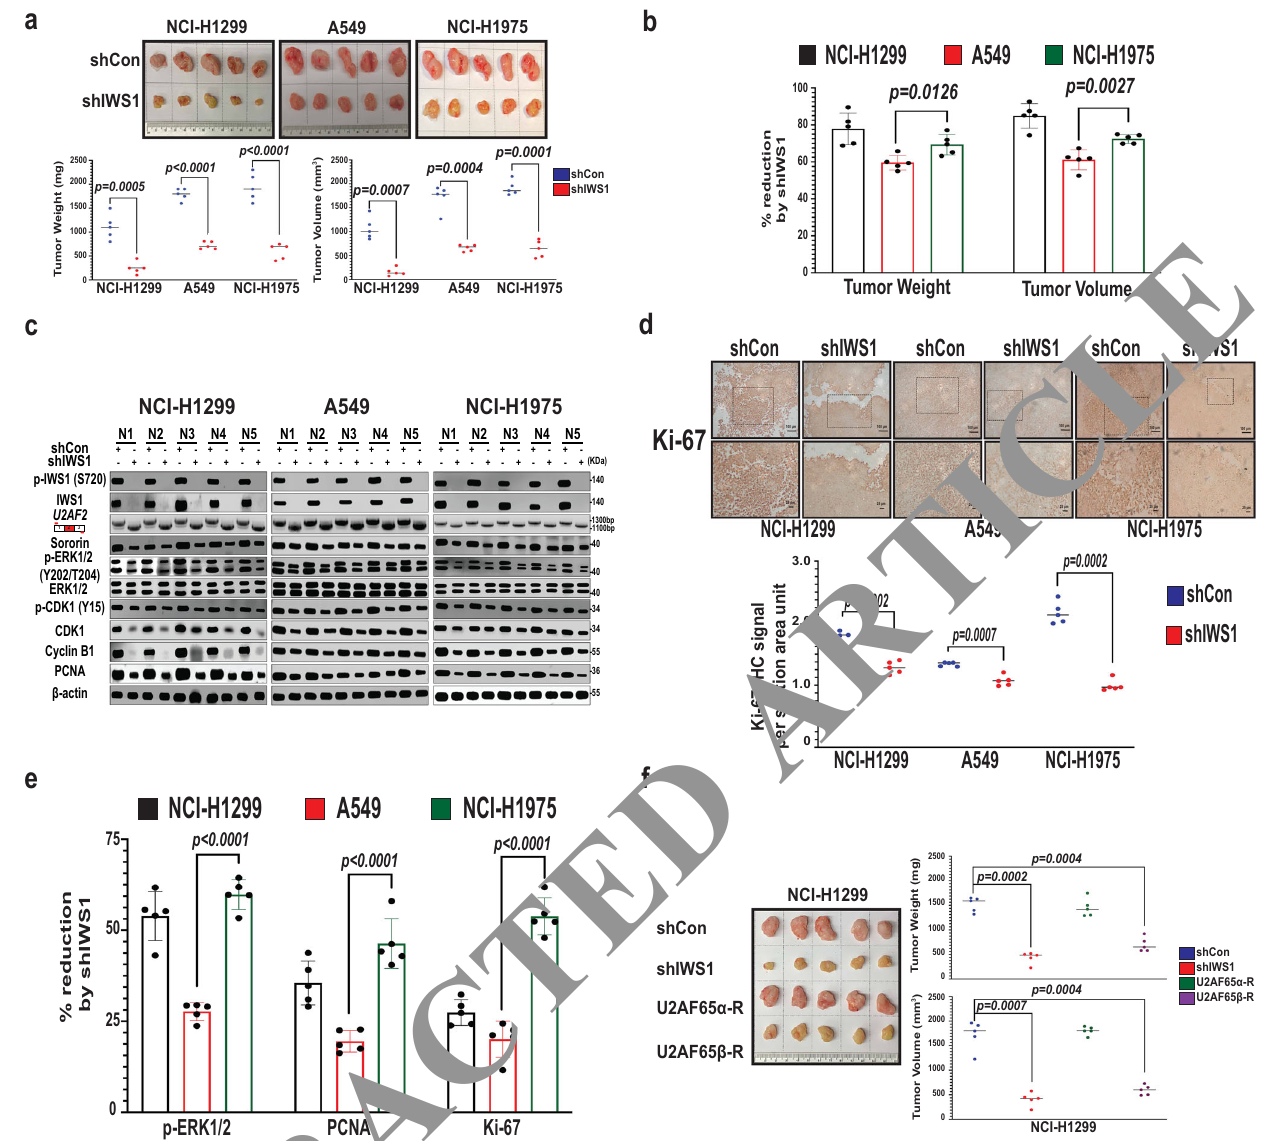
Fig. 7 IWS1 phosphorylation controls tumour growth in vivo, by regulating the U2AF2/Sororin/ERK axis. a (Upper panels) NSG mice were injected subcutaneously with shControl or shIWS1 NCI-H1299, A549, or NCI-H1975 cells. ( N = 5 mice/group). Images of tumors, harvested at 4 weeks (NCI- H1299, NCI-H1975) or 6 weeks (A549) from the time of inoculation. (Lower panels) Scatter plots showing the weight and volume of individual tumors. The horizontal lines indicate mean tumor weight or volume. Statistical analyses were done using the one-sided paired t -test. b shIWS1-induced percent reduction of tumor weight and tumor volume, calculated from the weight and volume of the tumors induced by shIWS1 and shControl cells in panel a . Bars show the mean percent reduction±SD. Statistical analyses were done using the one-sided unpaired t-test. c Cell lysates derived from NCI-H1299, A549 and NCI-H1975 (shControl and shIWS1) mouse xenografts, were probed with the indicated antibodies. RT-PCR on RNA from the same cells, using primers for U2AF2 exons 1 and 3. d (Upper panels) The indicated shControl and shIWS1, formalin- fi xed, paraf fi n-embedded tumor samples were stained with the Ki-67 antibody. Boxes in the upper images delineate the area of higher magni fi cation shown in the lower images. Scale bar in the right lower corner of each image. (Lower panels) Scatter plots show the Ki-67 IHC signal per section area unit in shControl and shIWS1 tumors. The horizontal lines show mean Ki-67 signals. Statistical analyses were performed, using the one-sided paired t -test. e ShIWS1-induced percent reduction of the phosphor-ERK, PCNA and Ki-67 signals in the xenograft tumors. Bars show the mean signal reduction, based on quanti fi cation of the Western blot data in panel c (p-ERK and PCNA) and IHC data in fi gure 7e (Ki-67) ± SD. Statistics were performed using the one-sided unpaired t -test. f (Left panels) shControl, and shIWS1 NCI-H1299 cells, as well as shIWS1 NCI-H1299 cells rescued with U2AF65 α , or U2AF65 β , were injected subcutaneously in NSG mice, as in the experiment in panel a ( N = 5 mice/group). Images of tumors harvested at 4 weeks from the time of inoculation. (Right panels) Scatter plots showing the weight and volume of the harvested tumors. The horizontal lines indicate mean tumor weight or volume. Statistical analyses were performed with the one-sided paired t -test. Analysis of the molecular signature dataset GSE13213, which (Fig. 8f, left panel). Sorting tumors harboring EGFR or KRAS focuses on tumor relapse 70 , revealed that the expression of IWS1 , mutations into separate groups, revealed that the activity of the CDCA5 , CDK1 , and CCNB1 (encoding Cyclin B1) was higher in a pathway was again higher, only in relapsing tumors with EGFR set of relapsing than in another set of non-relapsing LUADs mutations (Fig. 8f, middle and right panels, Supplementary NATURE COMMUNICATIONS| (2021) 12:4624